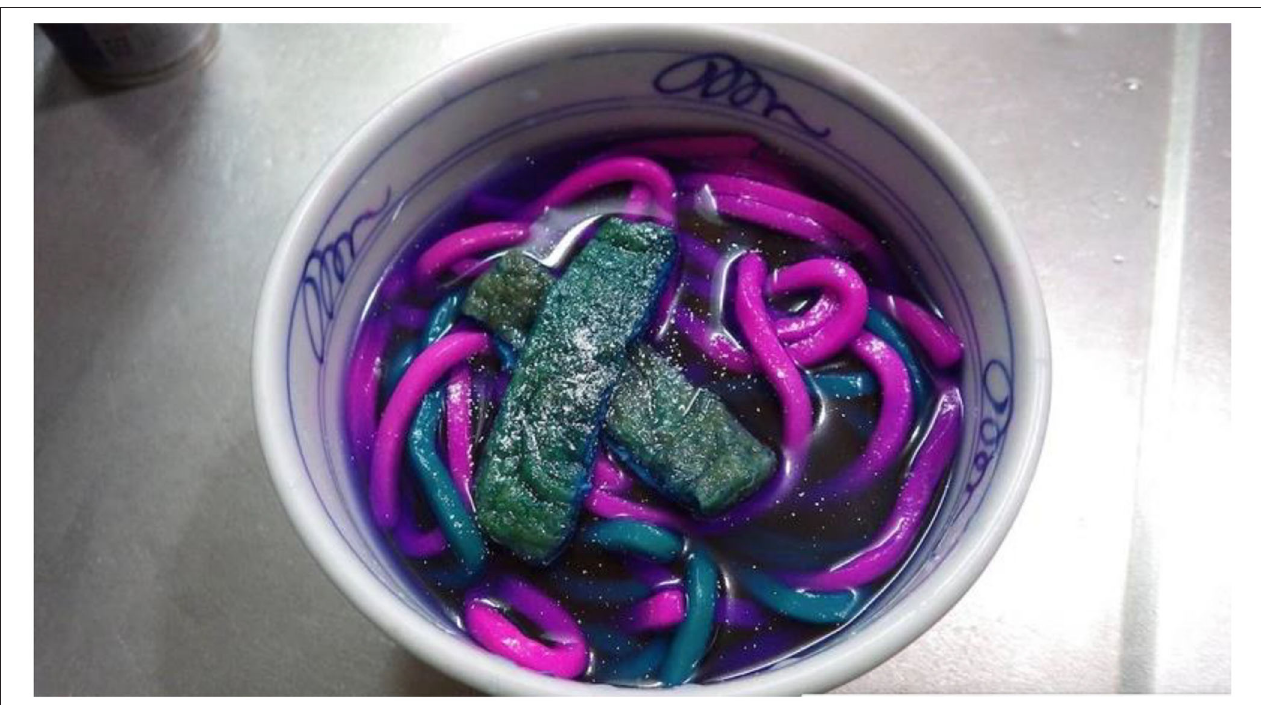
FIGURE 7 | Neon blue noodles created by Kurare. While such visually-captivating dishes generate a lot of interest online. How appealing are such dishes